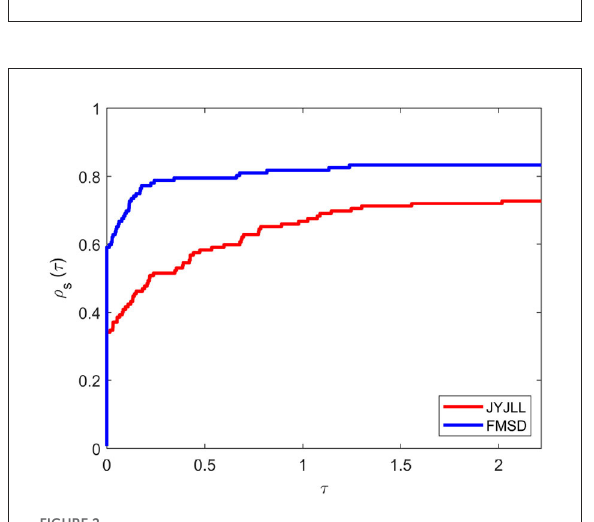
FIGURE2 Performance profiles on NOF.